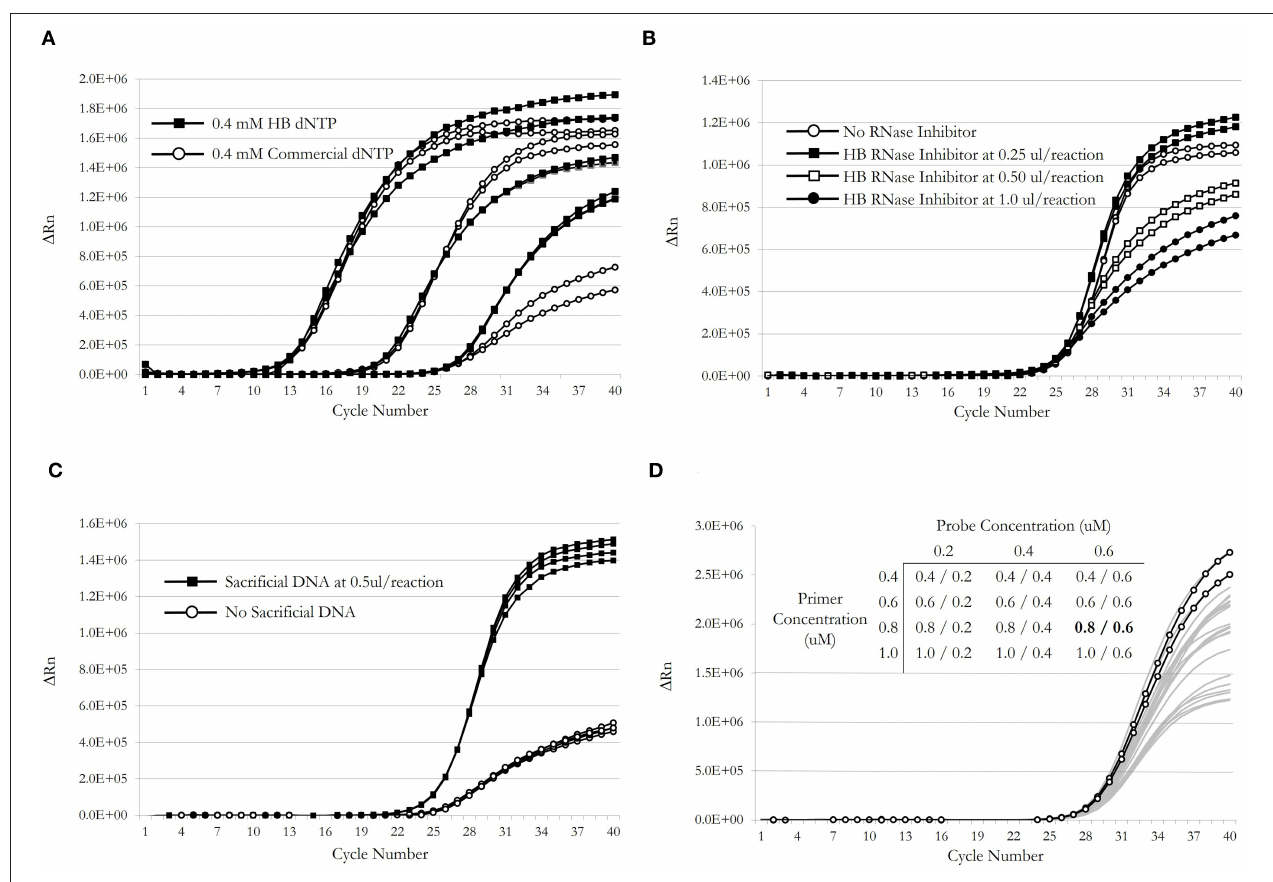
FIGURE 7 | (A) PCR performance comparison of HB dNTP product relative to a commercially manufactured equivalent over three log dilutions of template. (B) Effect of inclusion of HB RNase Inhibitor product on SARS-CoV-2 RT-qPCR for CDC N-gene at varying concentrations. (C) Effect of adding sacrificial DNA to the RT-qPCR reaction mixture to mitigate non-specific and premature reporter moiety cleavage. (D) A primer/probe (CDC N-gene) concentration matrix was used to determine optimal reagent concentrations.